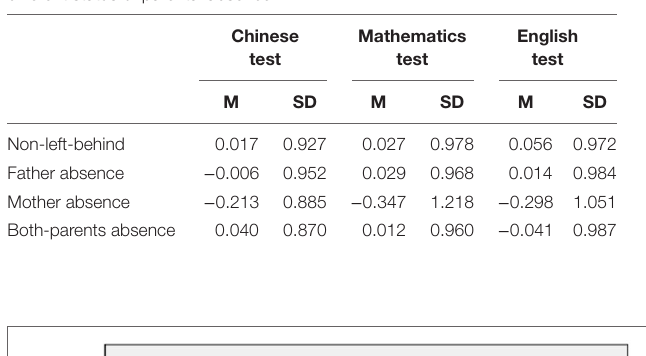
TaBle 1 | Descriptive statistics of the test scores (standardized) of children with different status of parental absence.